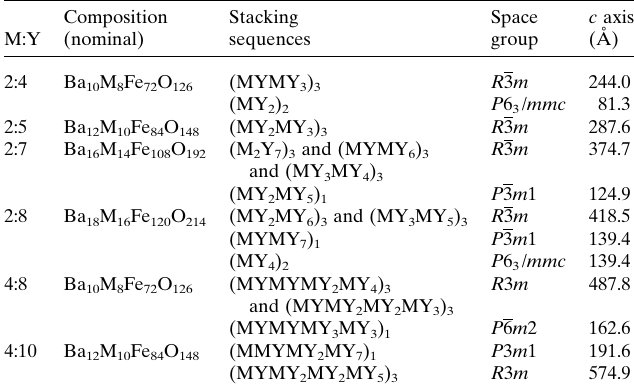
Table 3 Partial list of observed M p Y n mixed-layer hexaferrites (Kohn & Eckart, 1965 a , 1967; Kohn et al. , 1971) with compositions matching those reported in this study. The stacking sequence of M and Y blocks was derived from etched step edges measured with electron microscopy, or the intensities of the 00 l reflections in one-dimensional X-ray diffraction